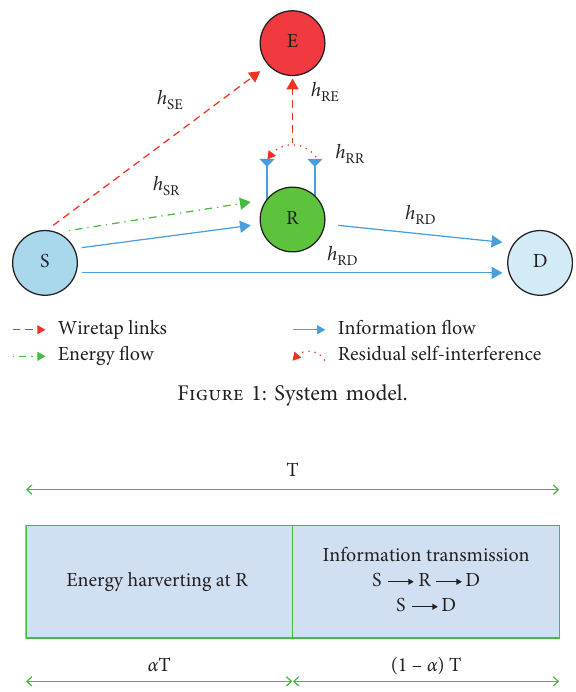
Figure 2: IT and EH